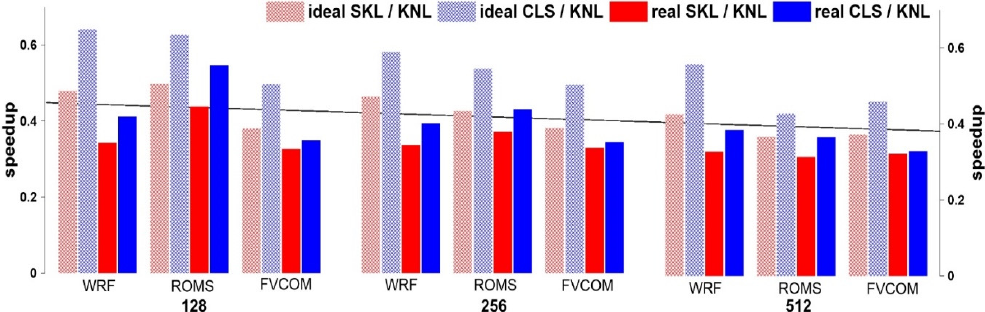
Figure 20. Parallelization efficiency by model (WRF, ROMS and FVCOM) depending on the number of cores (128, 256 and 512).